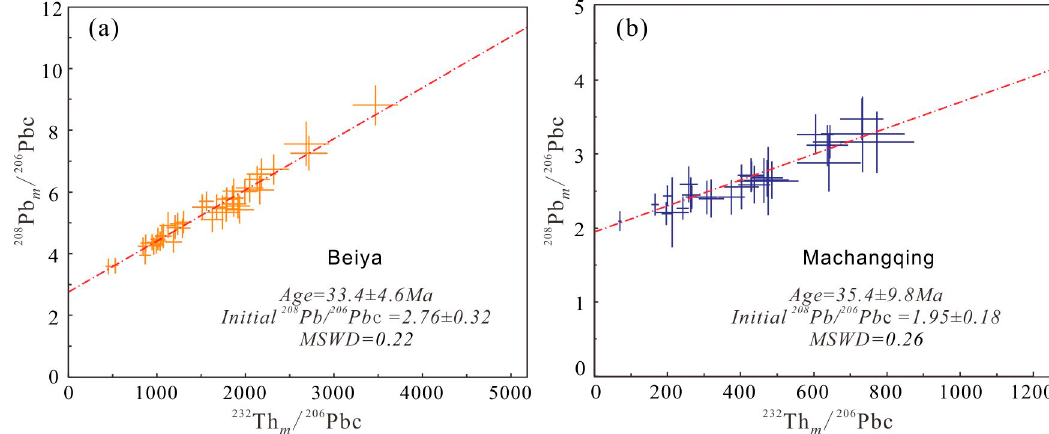
Figure 10. LA-ICP-MS Th-Pb isochrons of the allanite samples from: ( a ) the Beiya deposit; and ( b ) the Machangqing deposit.